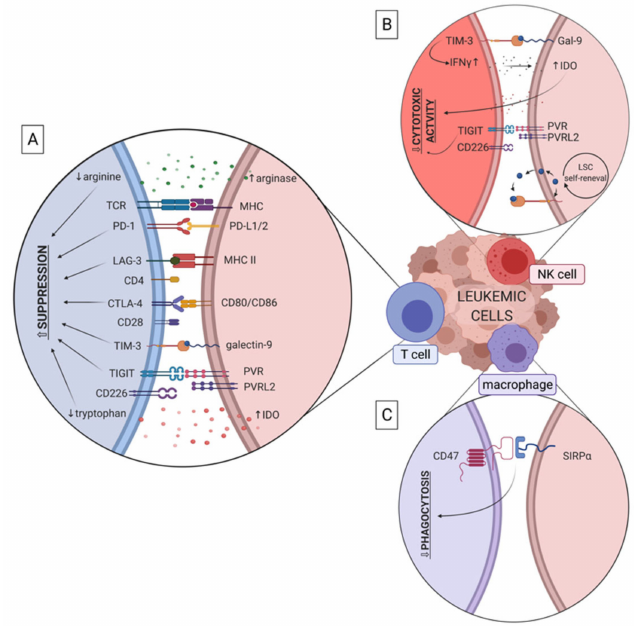
Figure 3. Receptors and factors expressed/released by myeloid leukemia cells to evade effector immune response (T cells, NK cells, macrophages). Leukemic cells (in brown), and their interactions with T cells (blue, panel A), NK cells (red, panel B) and macrophages (violet, panel C) are presented. TCR–T cell receptor; MHC–major histocompatibility complex; IFN- γ –interferon γ ; LSC–leukemia stem cell. Other abbreviations are explained in subsections (3.1.–3.9.) of chapter